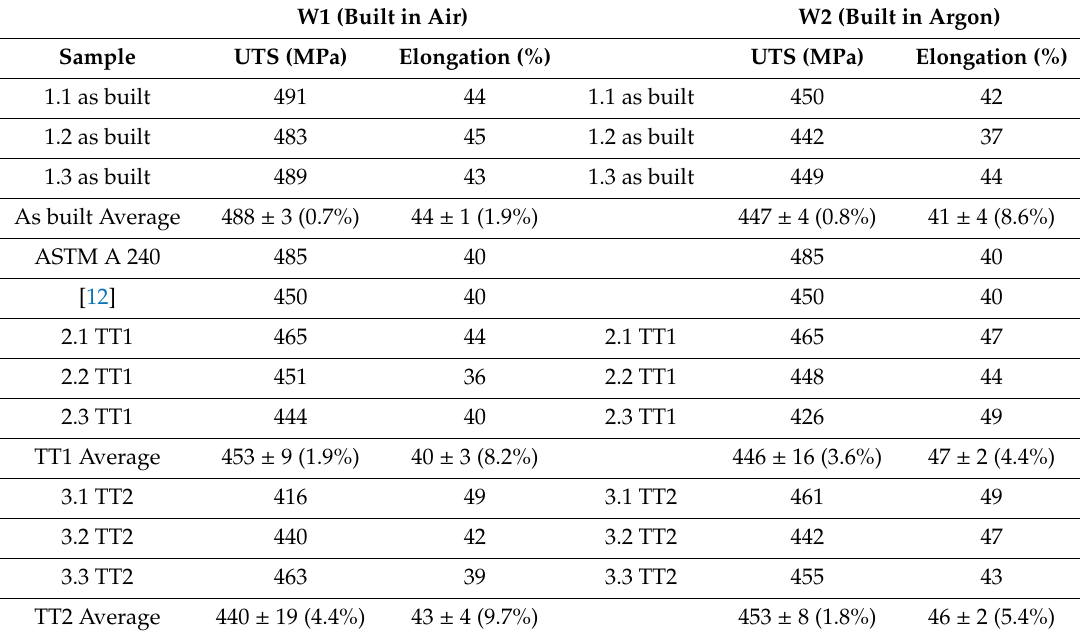
Table 4. Ultimate tensile strength and elongation results for the specimens